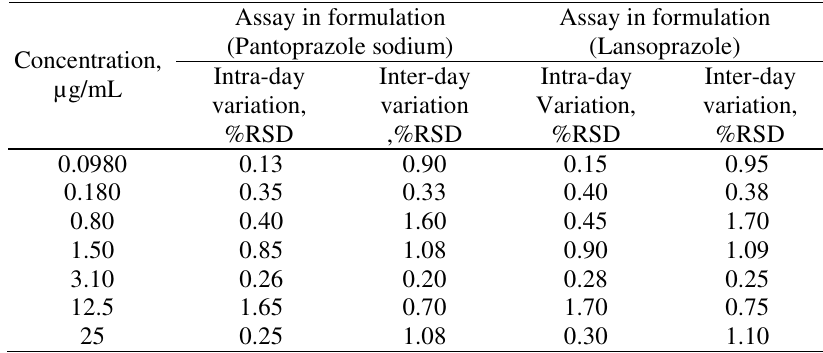
Table 2. Intermediate precision of the